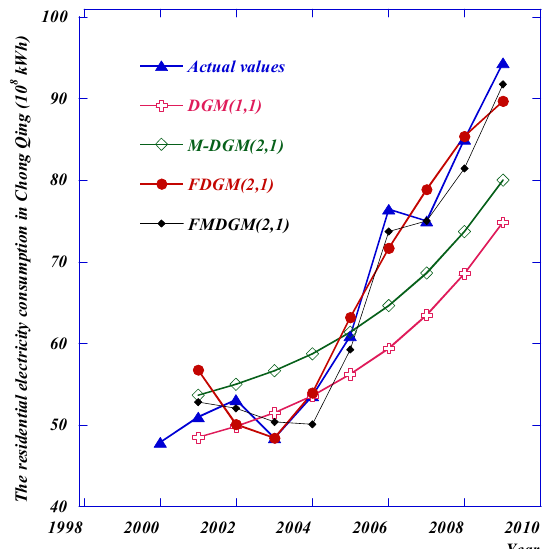
Figure 3. Comparison of the forecasting capability of different DGM(2,1) models for residential electricity consumption.